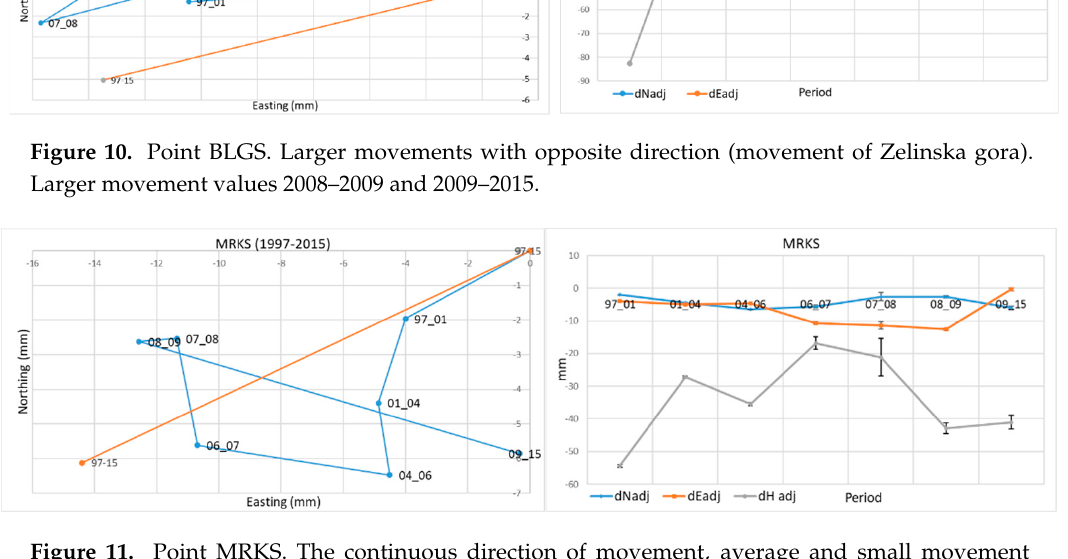
Figure 11. Point MRKS. The continuous direction of movement, average and small movement values. The condition between the movement of Zelinska gora and elevation of the Sljeme mountain (less active part).